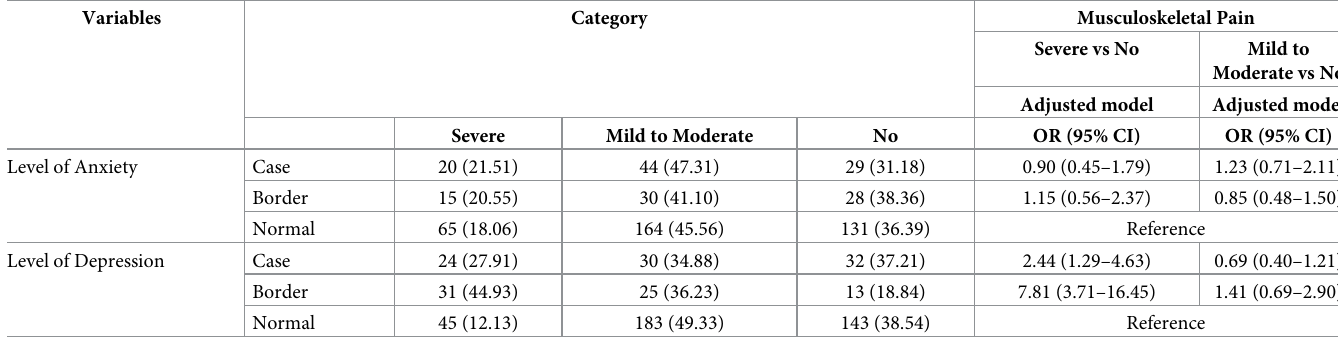
Table 3. Logistic regression analysis with anxiety and depression with musculoskeletal pain (multinomial logistic regression).